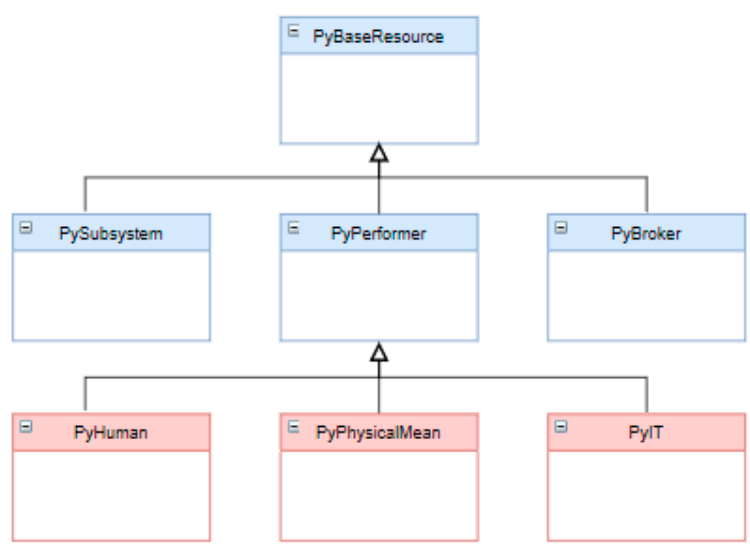
Figure 4. Extension of the PyBPMN metamodel to add the three types of resources.